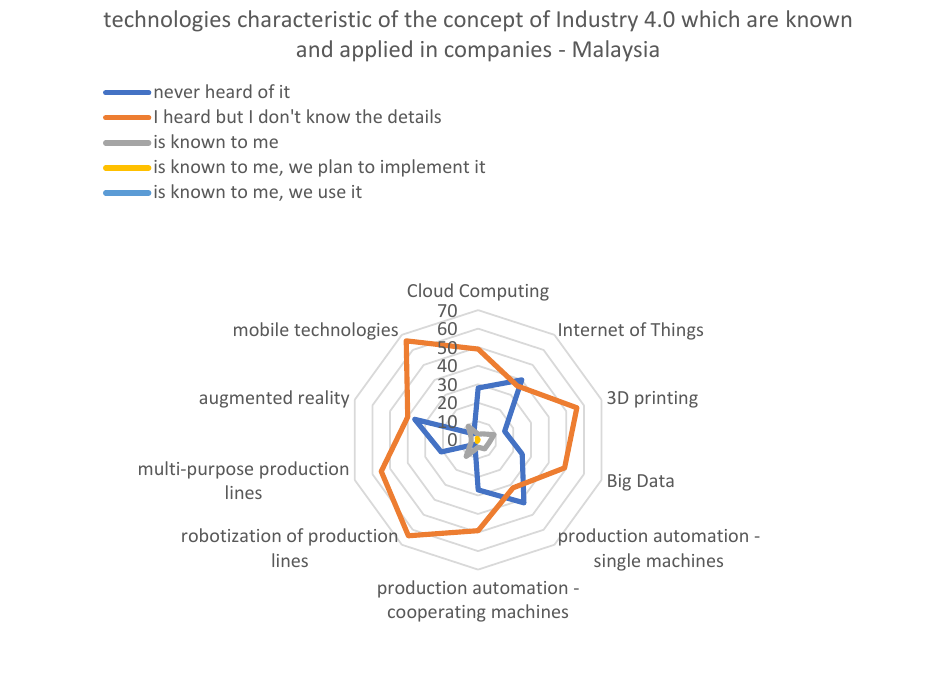
Figure 2. Technologies characteristic of the concept of Industry 4.0 which are known and applied in companies Malaysia. Source: elaborated by the authors.